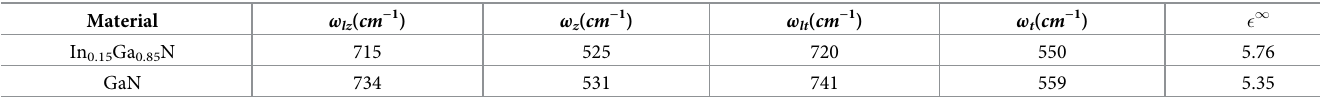
Table 1. Material constants used in the present calculations for wurtzite GaN/InGaN/GaN QW.